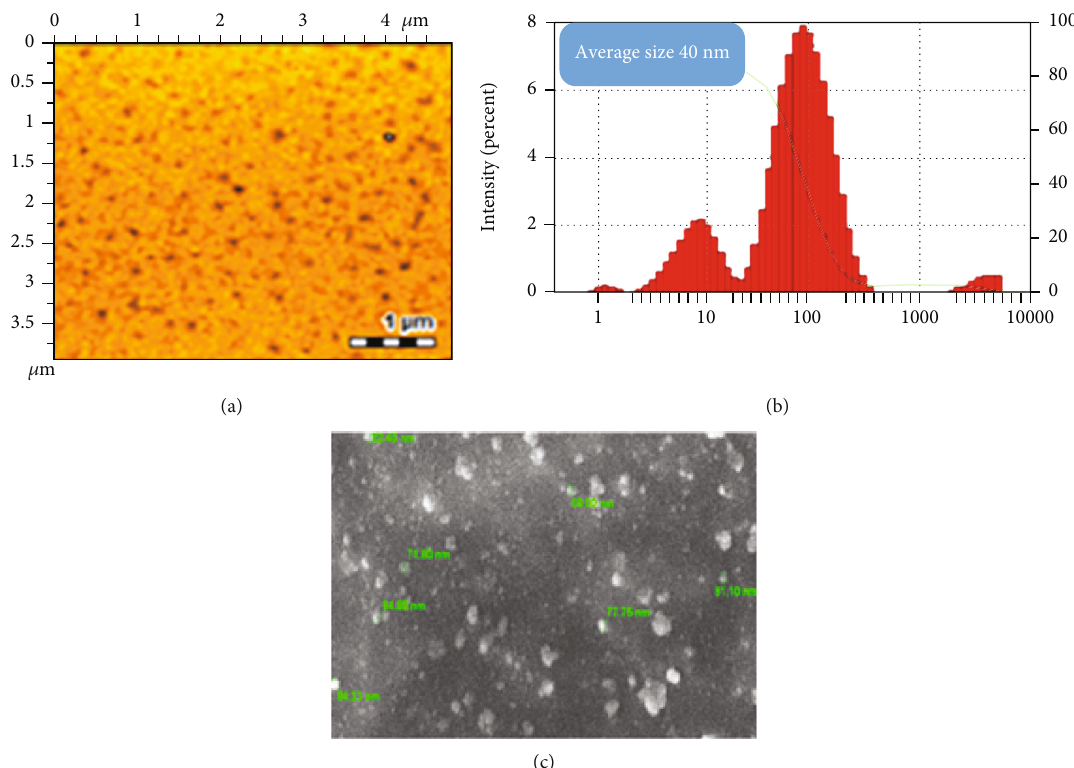
Figure 3: (a) Two-dimensional AFM images of ACR-AgNPs. (b) The percent intensity size distribution of ACR-AgNPs. (c) SEM image of